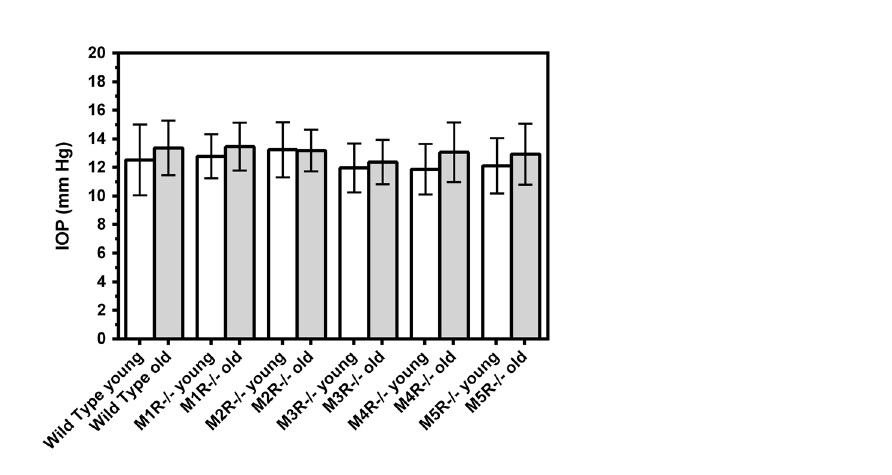
Table 1. Primer sequences for qPCR of the genes examined in aged wild-type and M1R − / − mice.